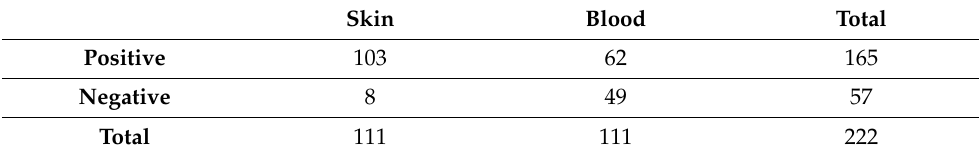
Table 1. Results of p32 real-time PCR for skin and blood samples collected from 111 animals.